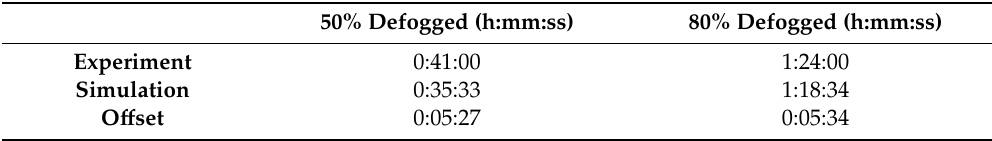
Table 10. Time comparison of defogging duration in case C2.